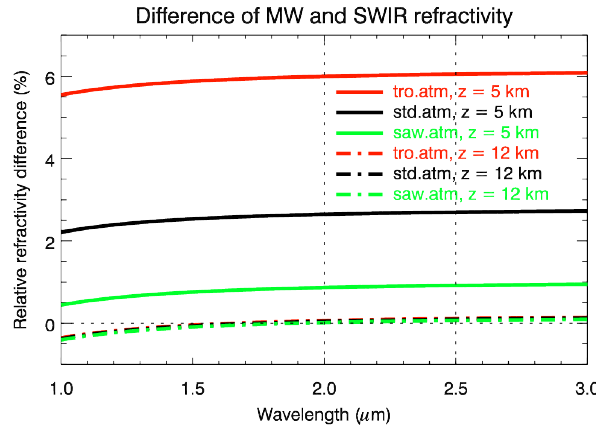
Fig. 2. Relative difference between the MW refractivity (Smith-Weintraub formula) and the SWIR refrac- tivity (improved Edl´en formula). The differences are shown for the FASCODE TRO, STD and SAW atmo- spheres at 5 km and 12 km (atmospheric conditions, p/T/e in hPa / K / hPa , for TRO 5 km : 559.0/270.3/1.87; STD 5 km : 540.5/255.7/0.76; SAW 5 km : 515.8/240.9/0.22; TRO 12 km : 213.0/223.6/0.01; STD 12 km : 194.0/216.7/0.00; SAW 12 km : 176.6/217.2/0.00).